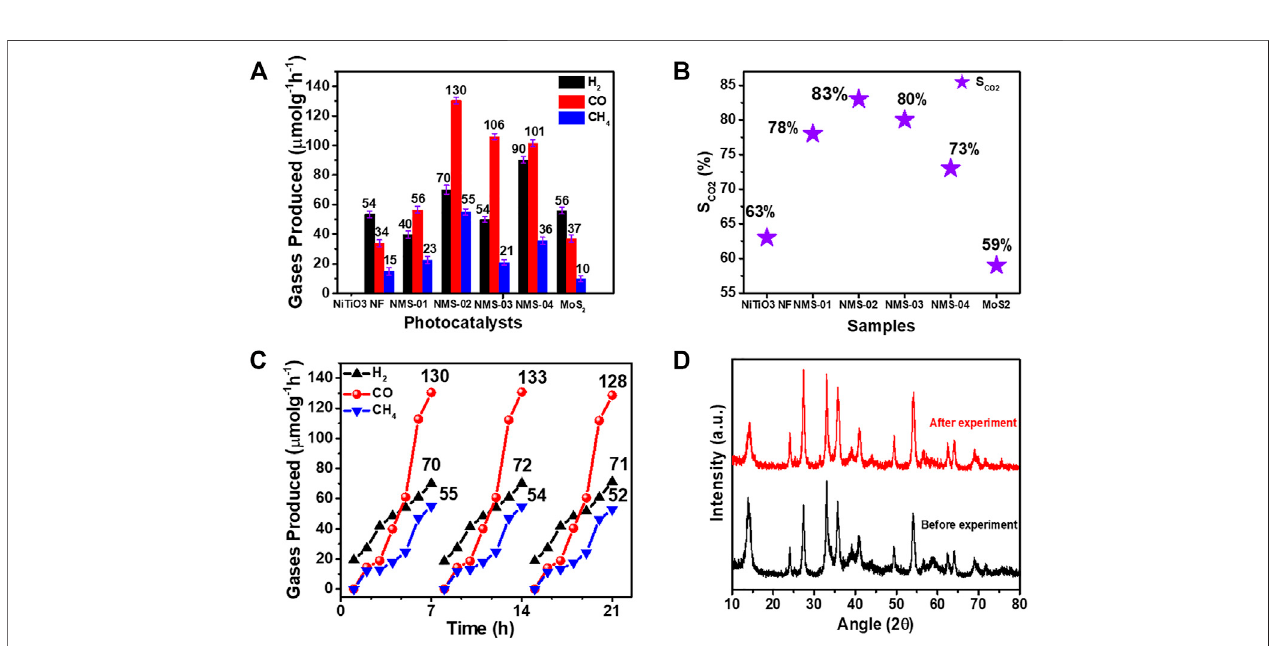
Frontiers in Chemistry |